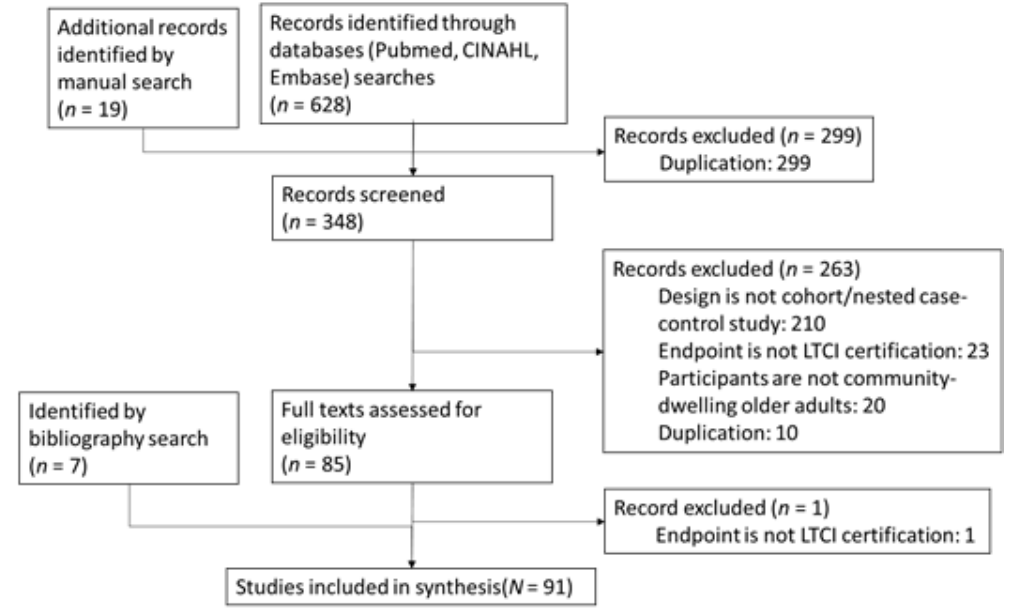
Figure 1. Flowchart of the literature